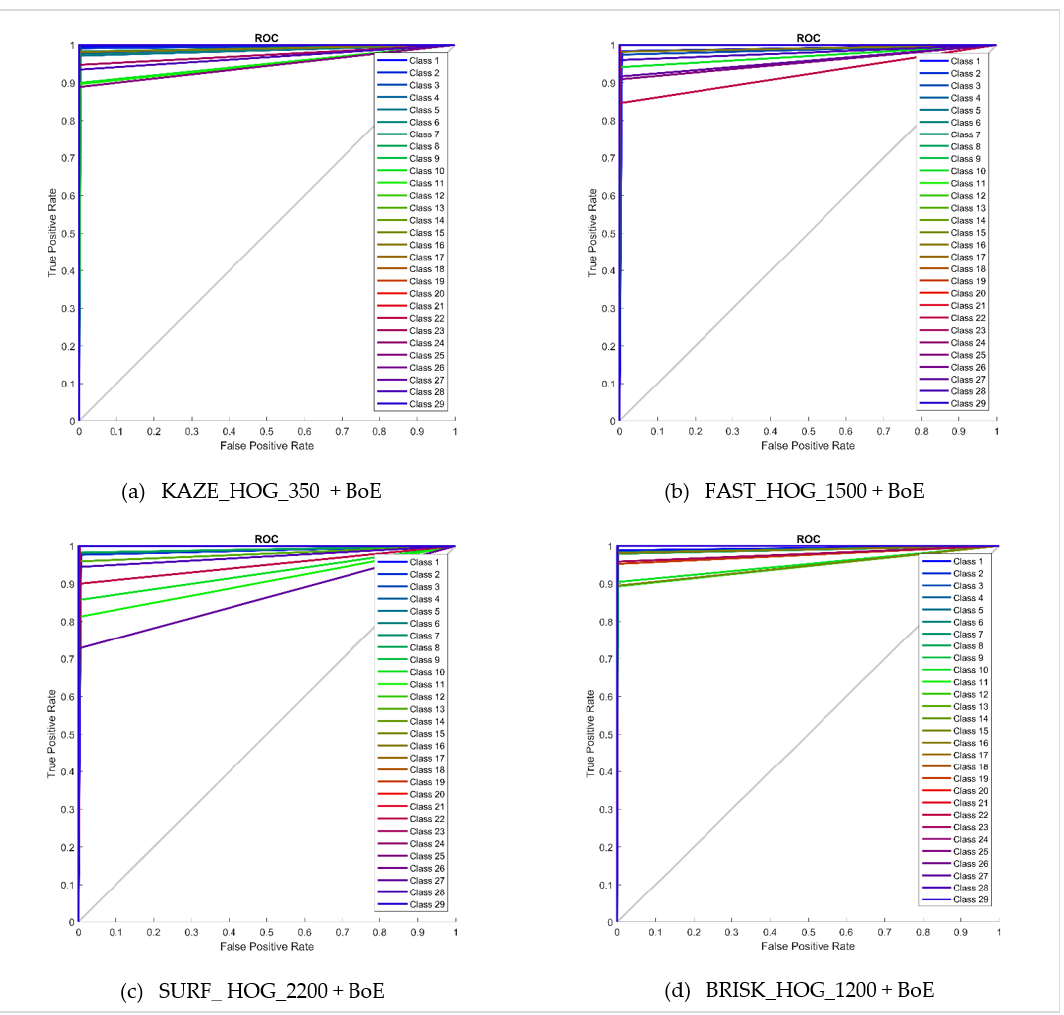
Figure 11. ROC curves for bag of expression for 80–20 NTOU-MMR